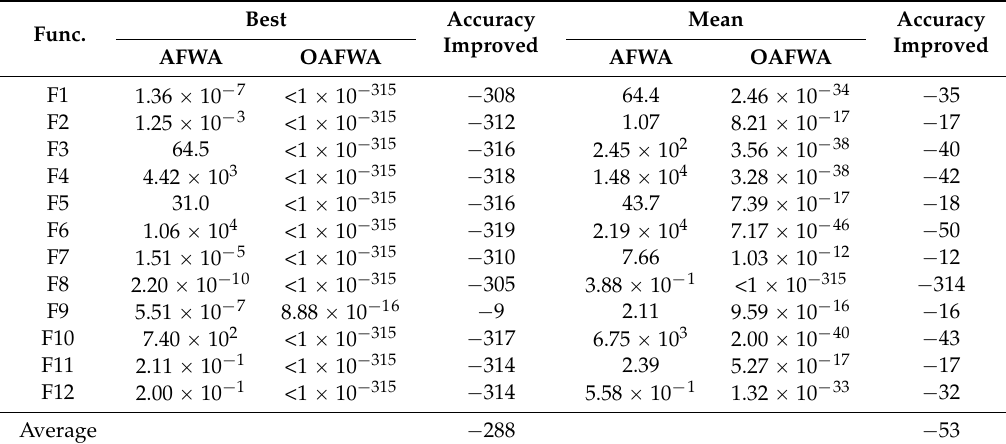
Table 4. Comparison of OAFWA and AFWA for solution